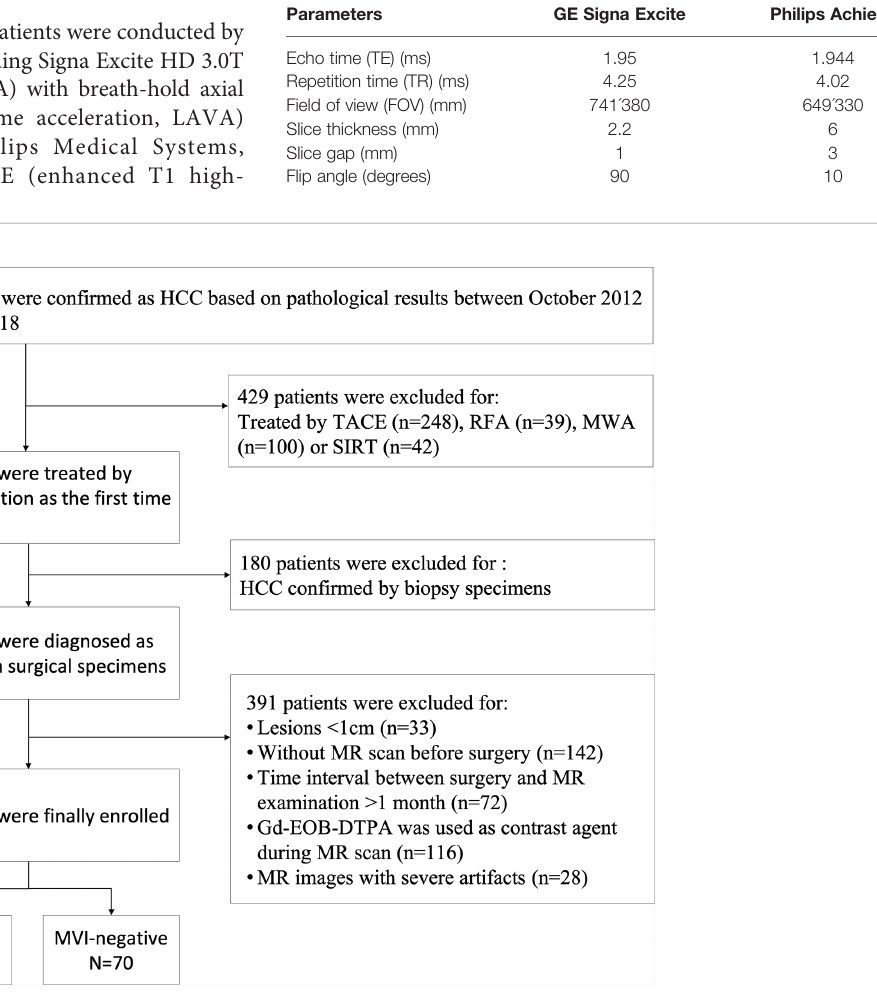
FIGURE 1 | Flow chart of patients ’ recruitment for the study. TACE, transcatheter arterial chemoembolization; RFA, radiofrequency ablation; MWA, microwave ablation; SIRT, selective internal radiation therapy.